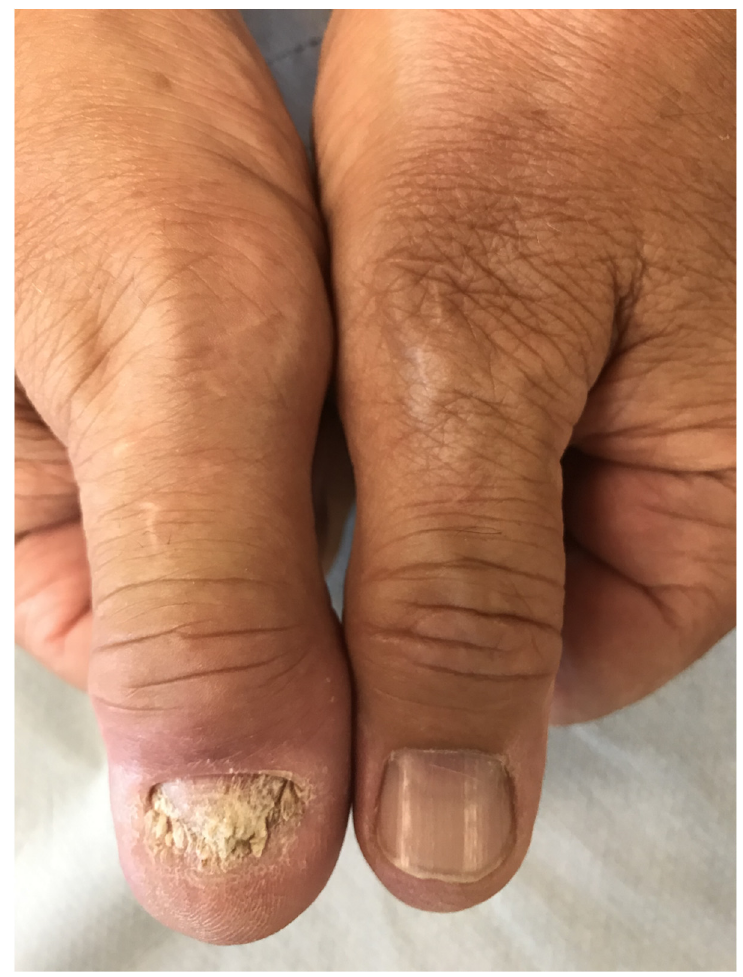
Figure 1. Photograph of hand dactylitis: The first finger of the right hand is affected by dactylitis. Image courtesy of Dr. Alen Zabotti.